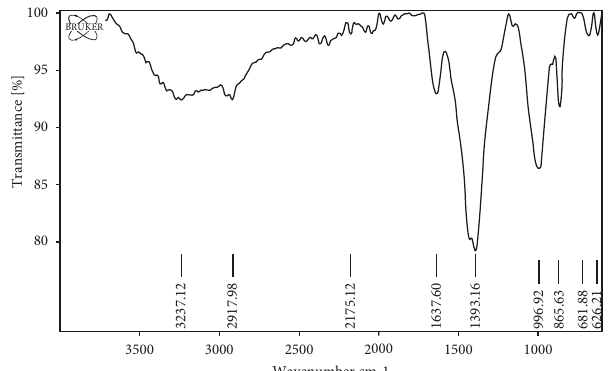
Figure 6: This chart is related to the results of FTIR test. The chart shows 9 peaks. Each of these peaks with the indicated wavelengths belongs to specific functional groups that have been involved in the synthesis or are known as nanoparticle stabilizers.